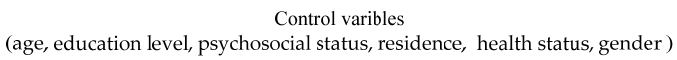
Figure 1. The relationship among family support, economic accessibility and realized utilization of healthcare services.